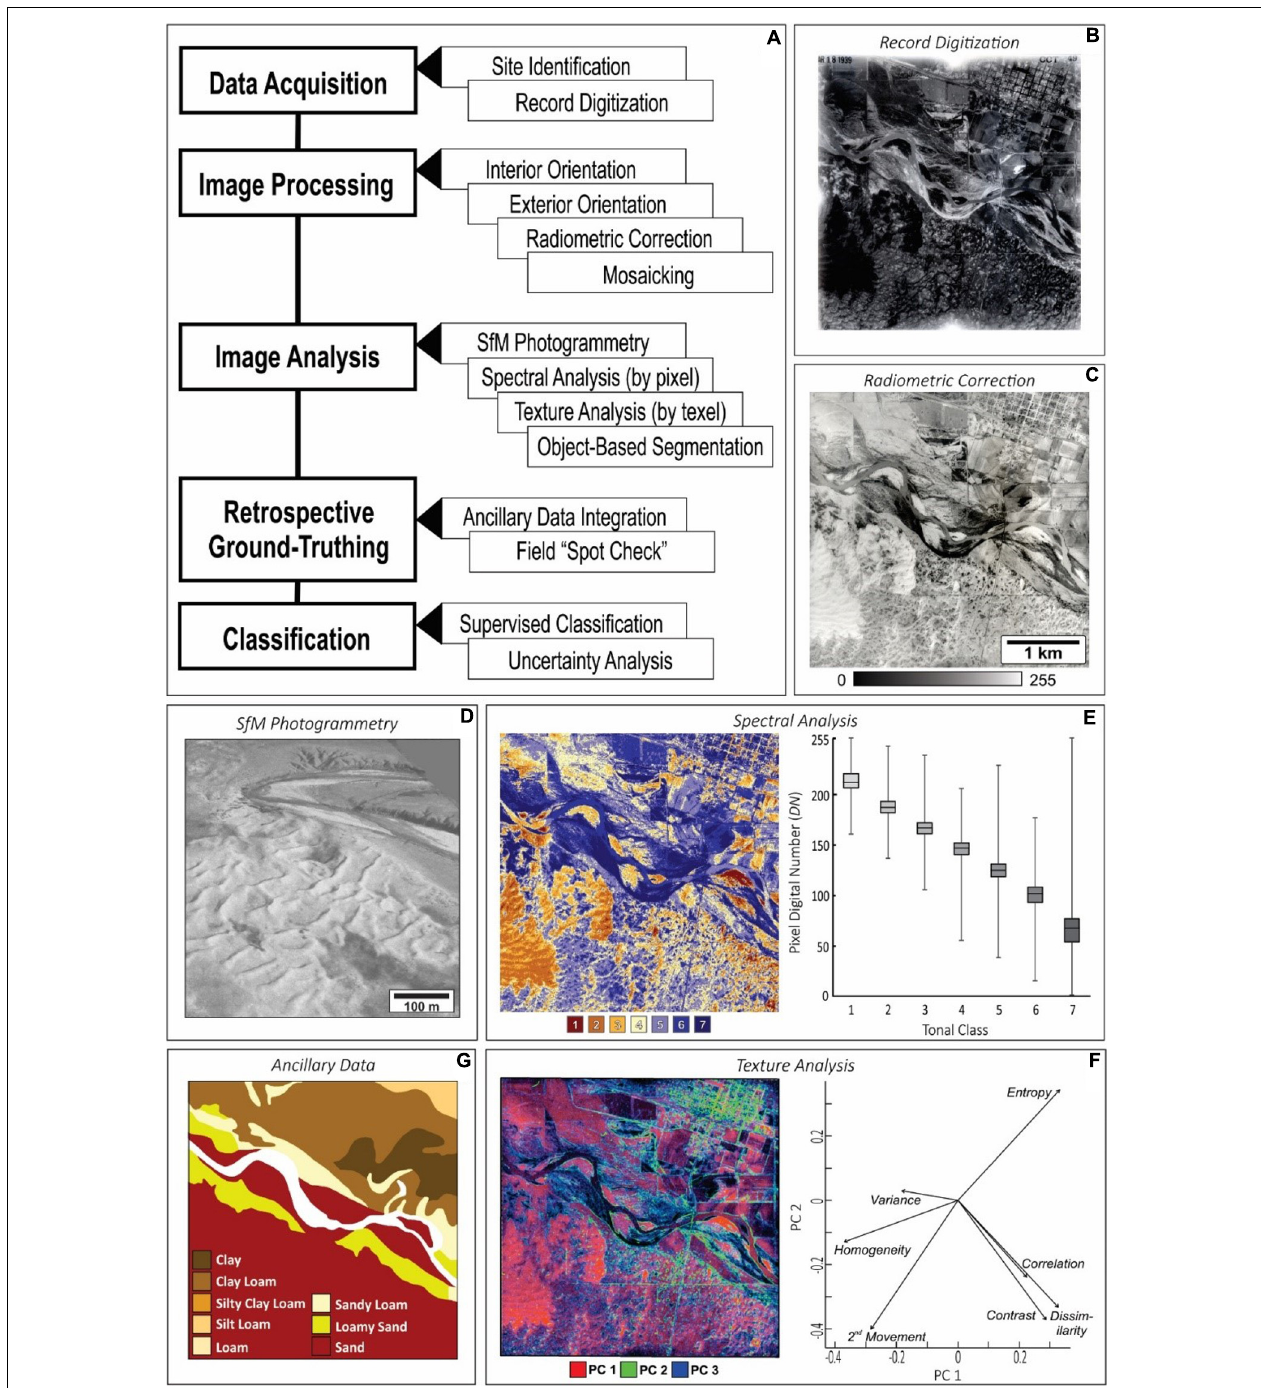
FIGURE 4 | Outline of semi-automated analysis of historical panchromatic aerial photographs used in this study with illustrative example: (A) diagrammatic workflow of methods used, (B) raw scan of original negative reel film of frame 145-CCT-049-155 from Syracuse, Hamilton County, KS taken March 22, 1939, (C) oriented, radiometrically corrected, and resampled image, (D) digital surface model (DSM) generated from multi-view stereoscopy, (E) results of unsupervised spectral classification of pixel digital numbers (DN) with box and whisker plot of cluster distribution, where the gray-scale color of the box in the plot corresponds to the mean DN of the cluster; refer to Table 4 for legend description, (F) results of principal component analysis of image texture layers to delineate image objects, (G) soil surface texture gathered from the Web Soil Survey (Soil Survey Staff [SSS] et al., 2017).